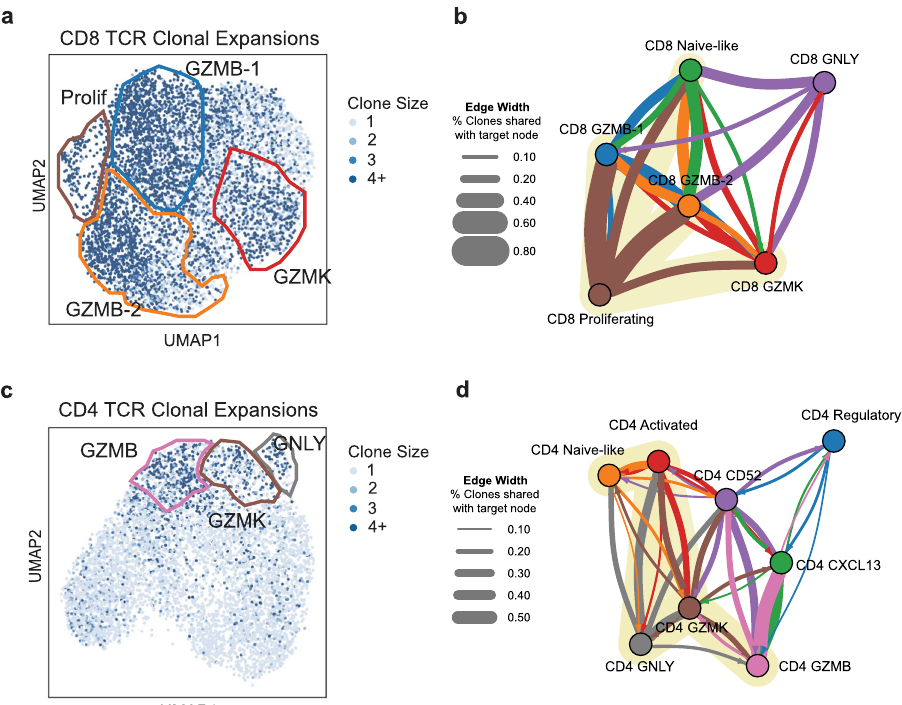
Fig. 3 Cytotoxic CD4 + and CD8 + T cells are clonally expanded in NSCLC. a UMAP projection showing the clone size associated with the TCR for each cell in CD8 + and c CD4 + T cells. b , d TCR clonal association between phenotypic states visualized using a graph structure. Each node represents a Leiden cluster and the width of each directed edge represents the percent of clones from the starting node shared with the target node. The color of each edge matches that of the starting node. Edges with weights in the lowest tertile for CD4 + and lowest quartile for CD8 + T cells are not shown for clarity. Source data are provided as a Source Data fi